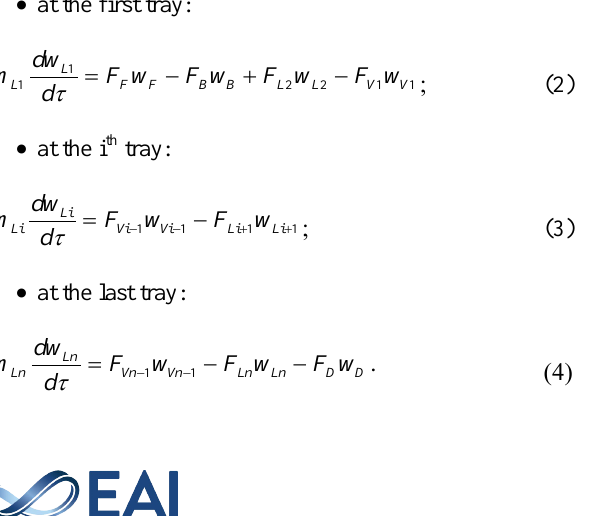
Figure 2. Equilibrium flash vaporization (EFV) curve Mass balance equation for the volatile component in each tray is formed as